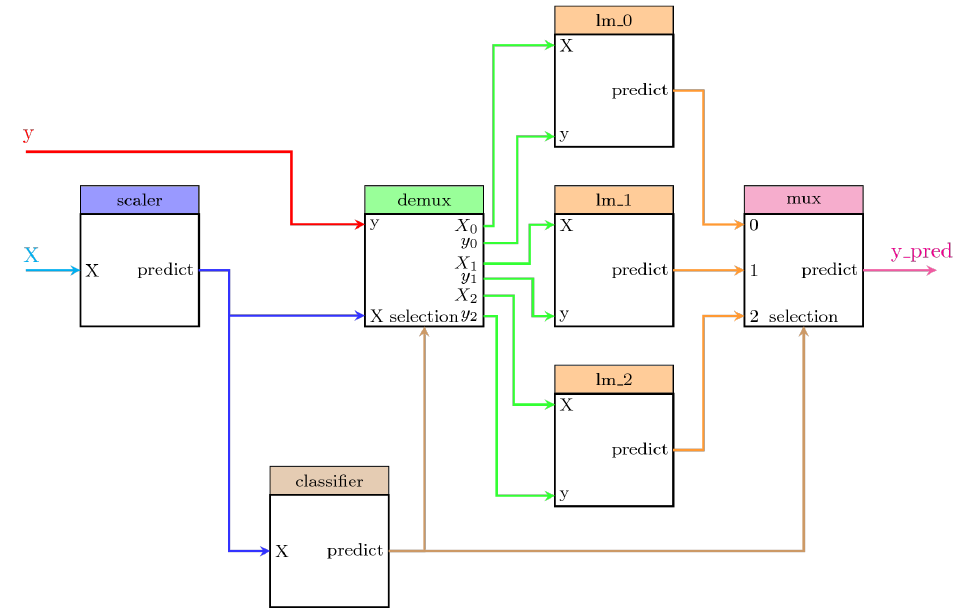
Figure 2. A PipeGraph system for fitting a different model per cluster. The code for creating an artificial dataset and configuring the system is described in Listing A1 of Appendix